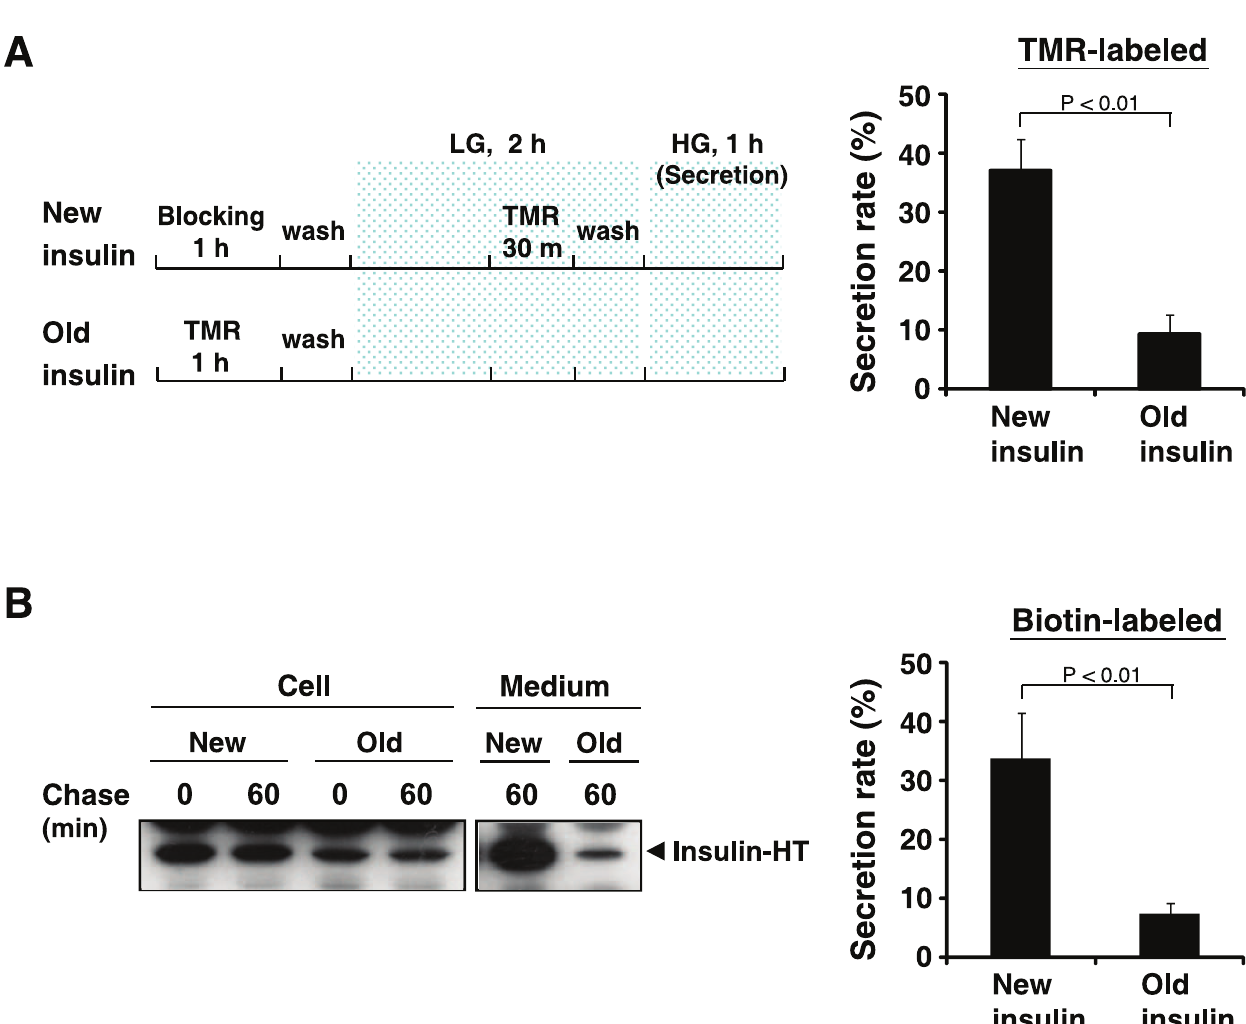
Figure 4. Newly synthesized insulin is preferentially secreted in response to high glucose. A and B, MIN6/insulin-HT cells were labeled with HT-TMR (A) or HT-biotin probe (B) for the indicated time as described in Methods (Scheme is shown in A). The cells were stimulated by high glucose (HG) for 1 hour, and the collected media and cell extracts were analyzed by fluorescence spectrometry (A) or immunoblotting with anti-biotin antibody (B). The intensity of each insulin-HT band was quantified with a densitometric imager. Cumulative data are presented as a percentage of the cellular insulin-HT protein levels at time 0 (before stimulation) as the mean 6 SE of three independent experiments.